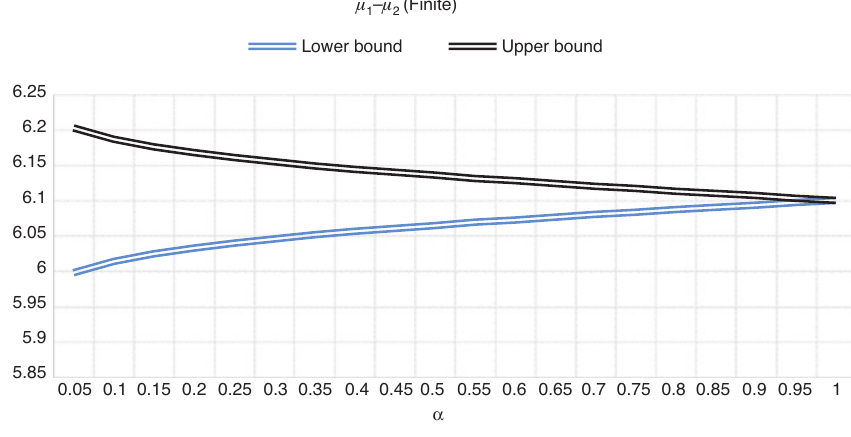
Figure 2: Confidence Intervals of Differences in Finite Population Means.